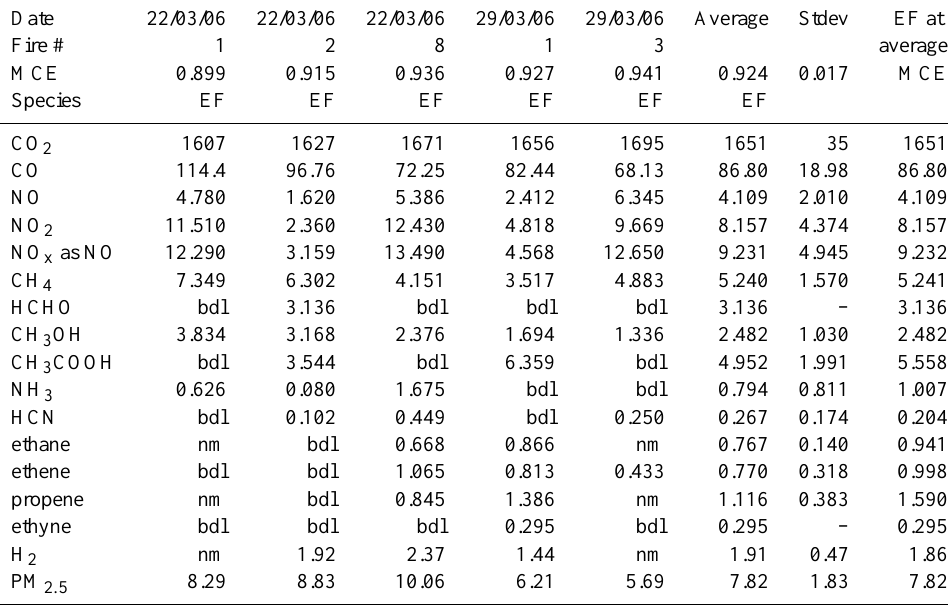
Table 4. Emission factors (EF, gkg − 1 ) and modified combustion efficiency (MCE) for fires burning mixed crop residue and tropical dry